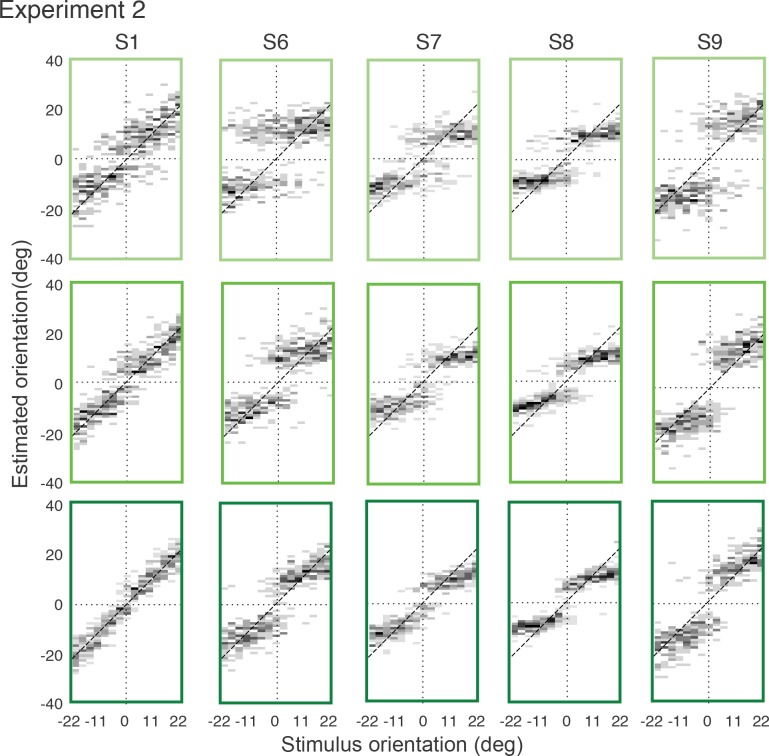
Full distributions of individual subjects’ estimates in Experiment 2.Each row corresponds to one of the three stimulus noise conditions (top-bottom: highest-lowest; color-code as in main text).